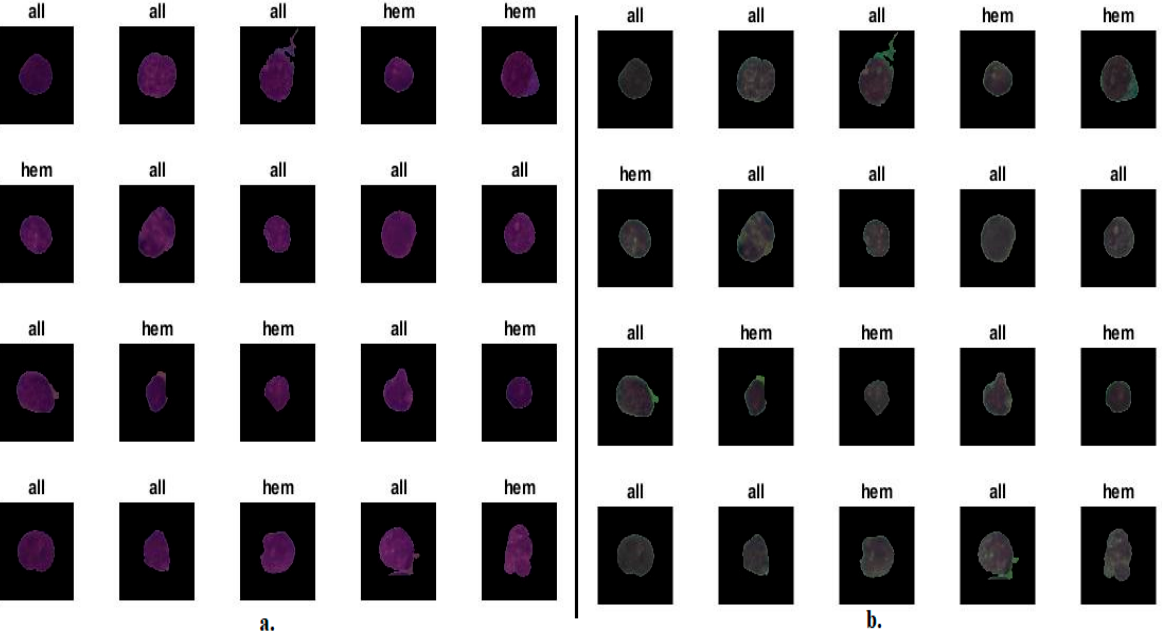
Figure 2. Random selection of images from the C-NMC 2019 dataset ( a ). Before improvement. ( b ) After improvement.